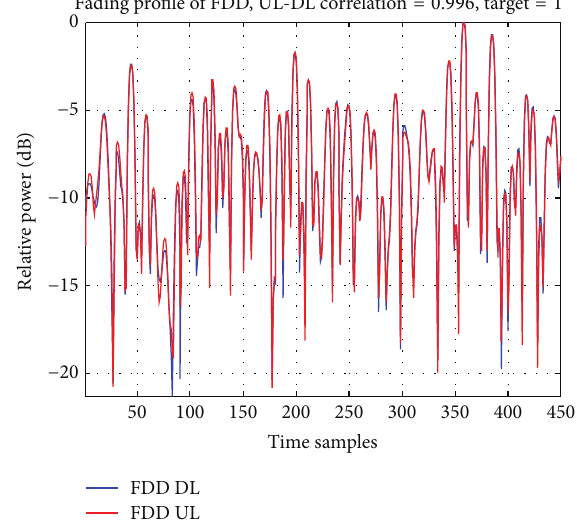
Figure 12: Measured fading profiles for the uplink and downlink for the FDD system. DL and UL denote the downlink and uplink,